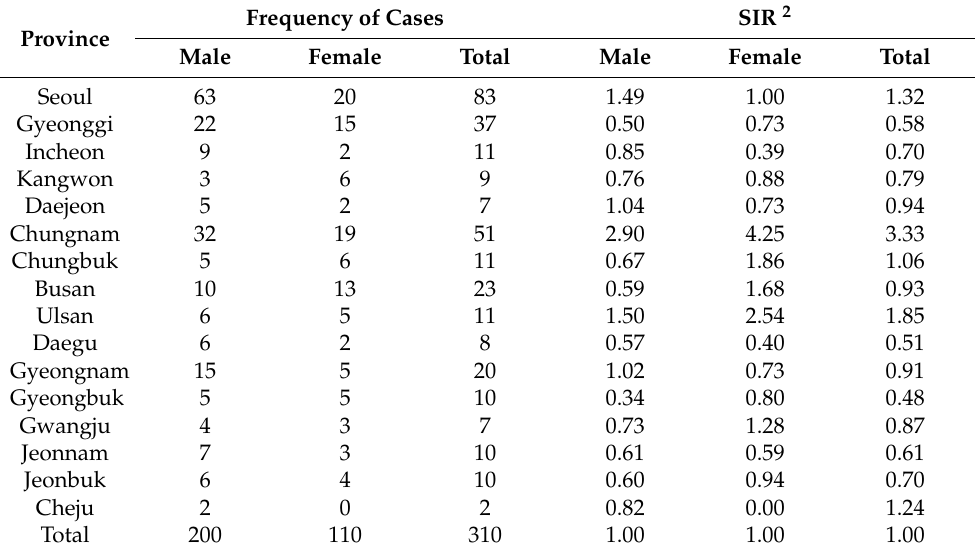
1 Standard population: 2009 regional age-specific Korean population. 2 SIR: standardized incidence